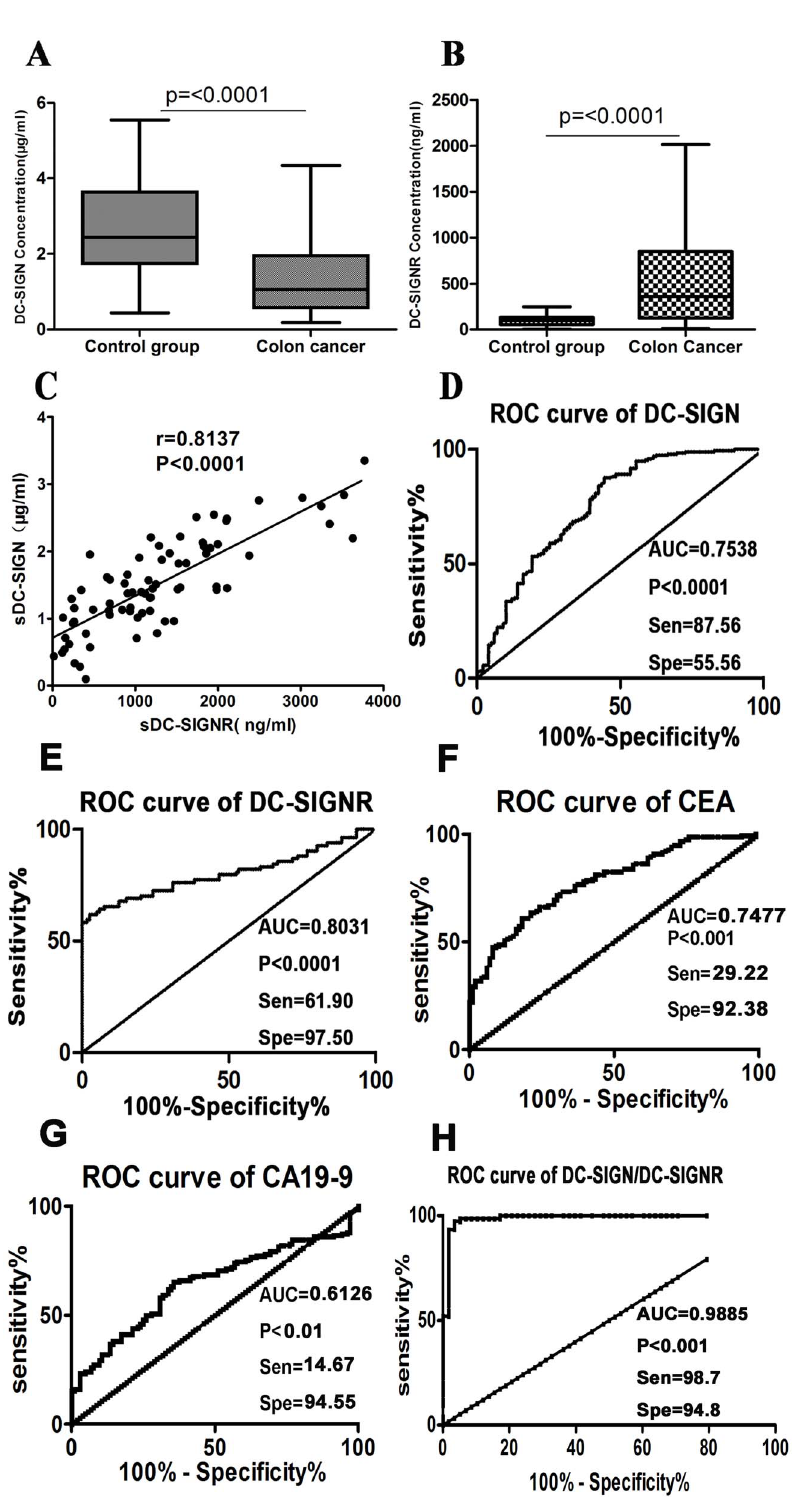
Fig. 1. The levels and diagnostic values of sDC-SIGN and sDC-SIGNR in colon cancer patients. A–B : There was statistical significance in the sDC-SIGN and sDC-SIGNR level between healthy controls and